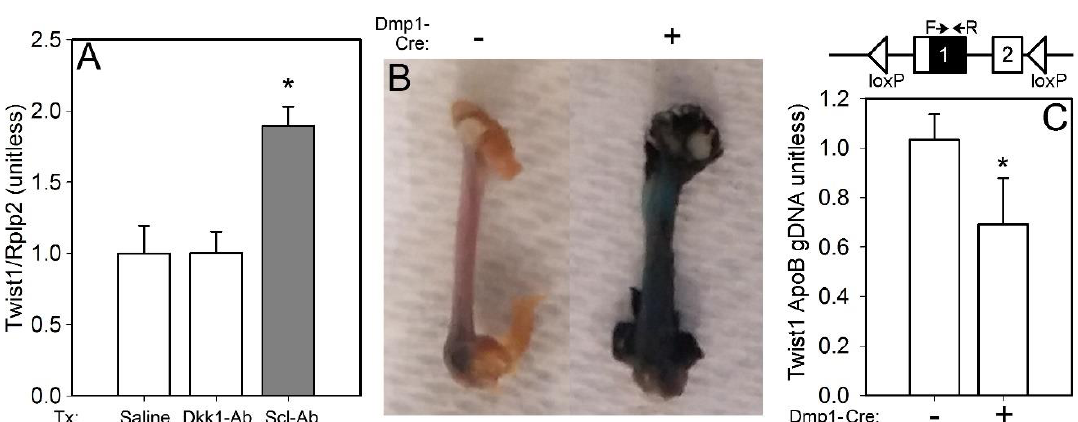
Figure 1. ( A ) Twist1 expression, normalized to the housekeeper Rplp2, was significantly increased in osteocyte-enriched bone tissue lysates from 10-wk-old female WT C57Bl/6J mice that were injected with a single dose of 25 mg/kg sclerostin antibody (Scl-Ab), then sacrificed 2 days later. The same procedure using Dkk1 antibody (25 mg/kg) did not change Twist1 expression; n = 4/group, * p < 0.05. ( B ) Representative micrographs of β-galactosidase-reacted femora from Twist1 f/f mice that also carried the Rosa26-LacZ Cre reporter line. Qualitatively, negligible lacZ staining is apparent in the Cre-negative mice, but the mice positive for 10kb Dmp1-Cre exhibit a strong reaction in the bone tissue, indicating recombination activity of the Cre transgene. ( C ) Top: schematic showing the floxed Twist1 locus (2 exons) and the location within exon 1 of the forward and reverse primers (arrows) used to probe for the intact floxed allele in genomic DNA from cortical bone. Bottom: ratio of intact Twist1 sequence (target) to Apolipoprotein B sequence (control), in Cre-positive and Cre-negative mice; n = 8–9/group, * p < 0.05.